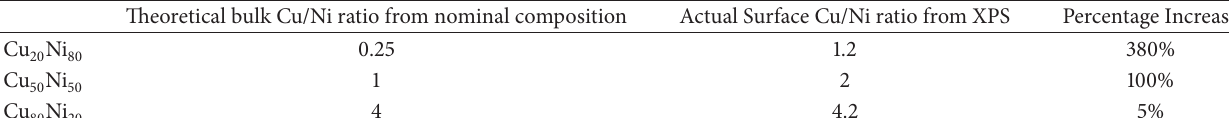
Table 2: Cu-Ni surface ratios obtained from XPS measurements.